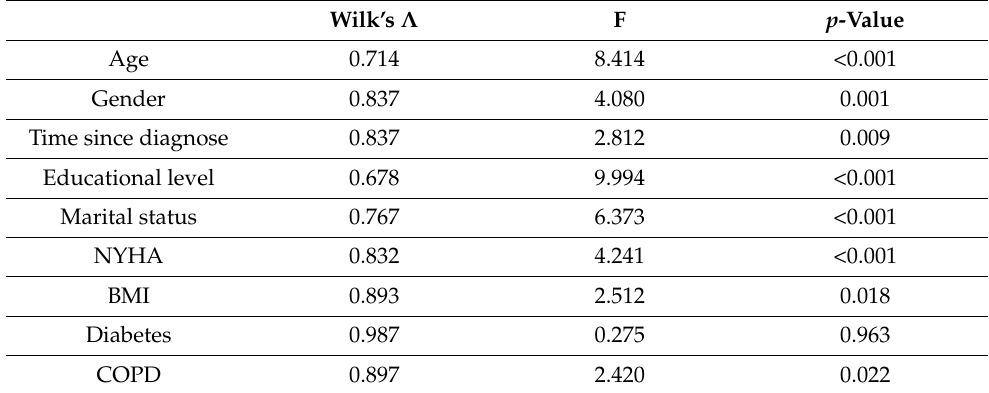
Table 3. Multivariate general linear model with physical activity readiness (physical and psychologi- cal readiness) as dependent